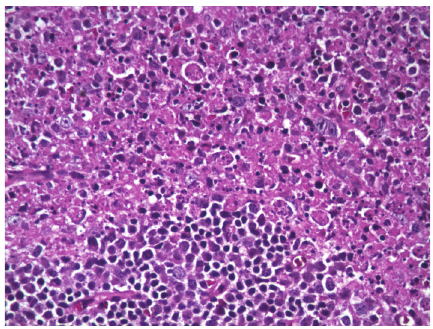
Figure 2: High magnification-lymph node with abundant karyor- rhectic debris with scattered fibrin deposits and large mononuclear